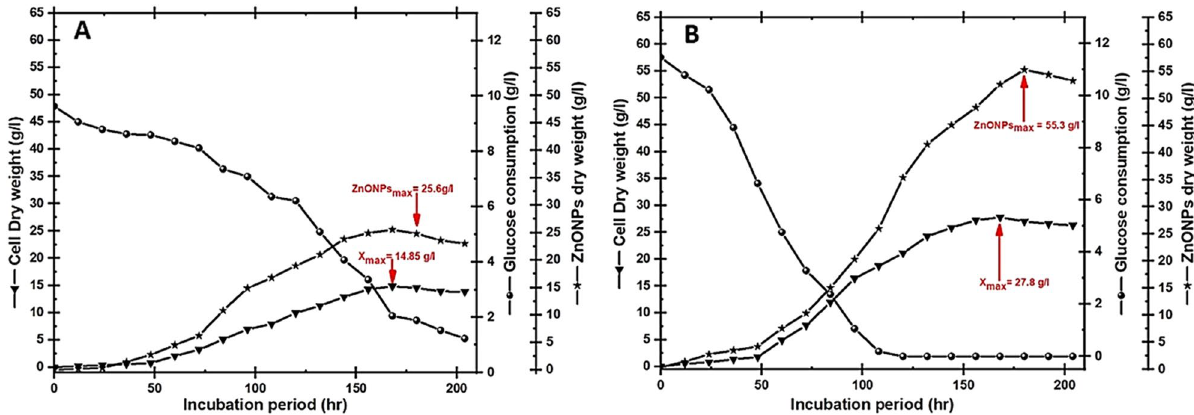
Figure 6. Represents the yields of the strain E56, biosynthetic ZnO NPs, and glucose consumption in two different fermentation programs: a 2-L flask system ( A ) and a 10-L stirred tank bioreactor ( B ) using batch- fermentation